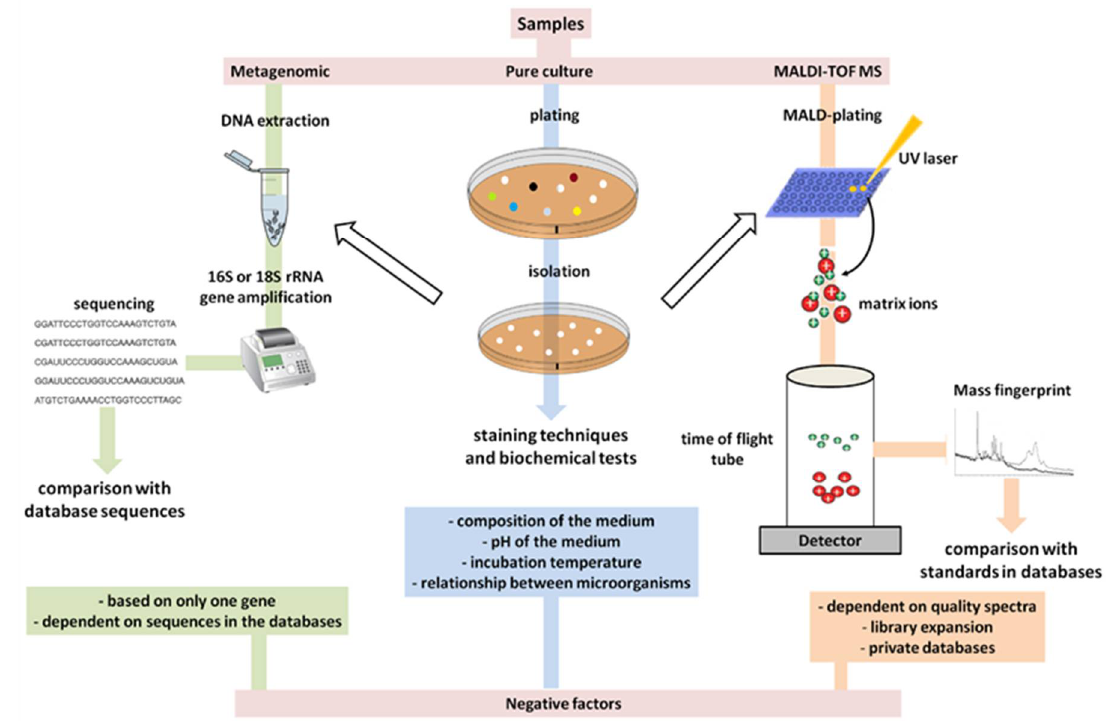
Figure 3. Description and aspects of methods currently available for microorganism classification. Microorganisms isolated from general samples can be identified by metagenomics, by pure culture combined with morphoanatomy analysis (staining techniques and biochemical tests), or by mass spectrometry.